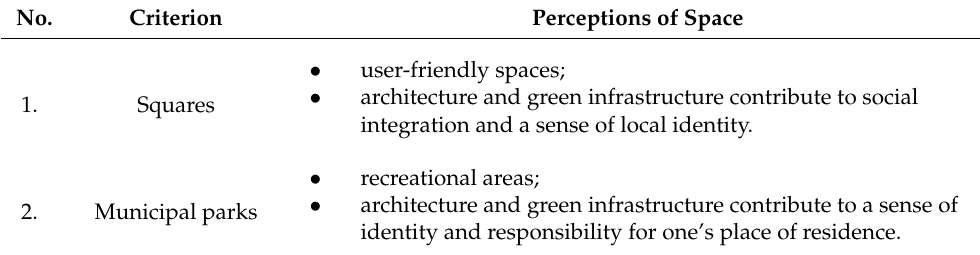
Table 5. The influence of urban open spaces on perceptions of space.